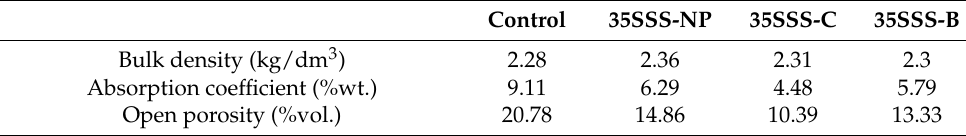
Figure 7. Tensile splitting strength versus compressive strength of SCC at 28 days. Table 8. Density, absorption, and porosity of alkali-activated